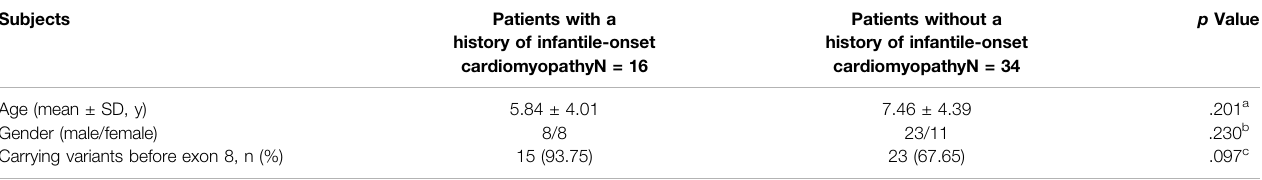
TABLE 5 | Genotype-Phenotype correlation for Infantile-onset cardiomyopathy ALMS patient. Subjects